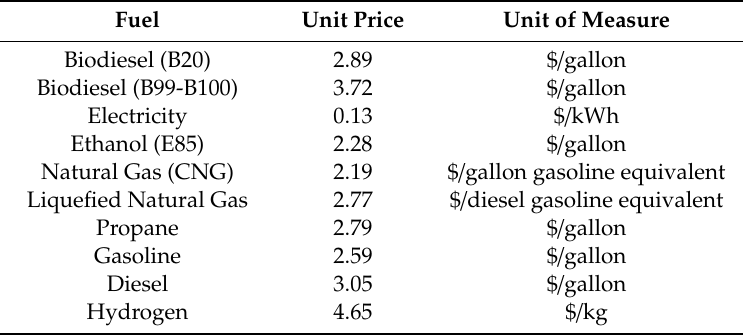
Table 5. Fuel prices from the US Department of Energy for Jan 2020 [64].